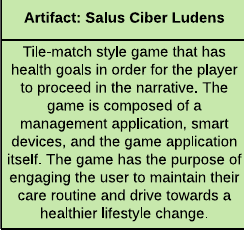
Figure 3. Artifact